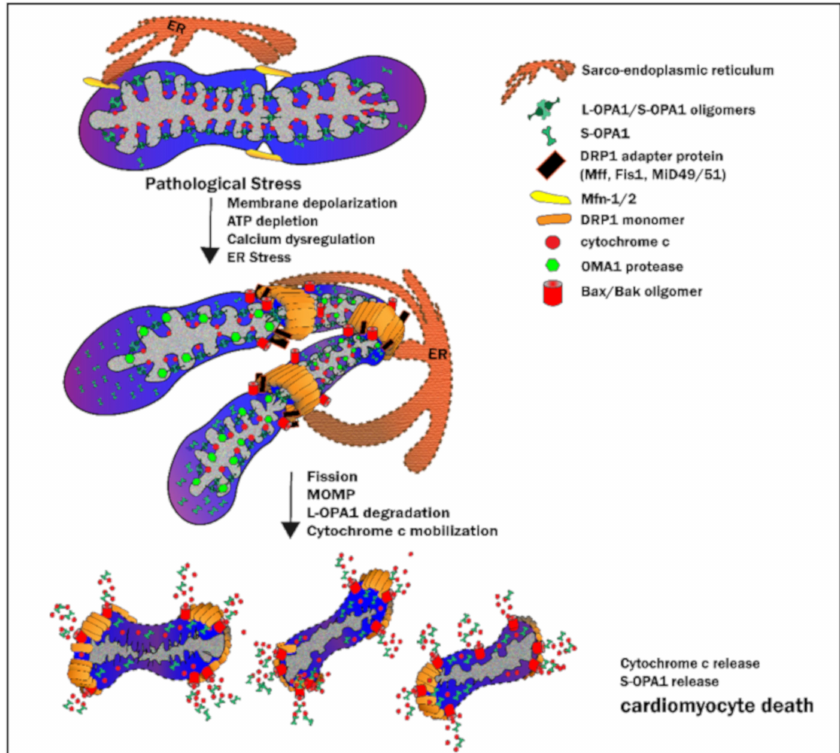
Figure 4. Mitochondrial morphosis under pathologic conditions. Ischemia-reperfusion is associated with an increase in DRP1-mediated fission, mitochondrial outer membrane permeabilization (MOMP) and the release of apoptogenic species into the cytoplasm. Degradation of OPA1 oligomers (achieved via stress-associated OMA1-mediated proteolytic cleavage of OPA1) disrupts cristae architecture, dissociating cytochrome c from within the cristae folds. MOMP is proposed to be a consequence of interaction of DRP1 with Bax / Bak oligomers at the outer membrane, and is considered to be a lethal event. Dysfunctional mitochondrial segments are represented in blue, viable mitochondria represented in purple. OPA1 = optic atrophy protein-1; DRP1 = dynamin related protein-1; Mfn 1 / 2 = mitofusins 1 & 2; MOMP = mitochondrial outer membrane